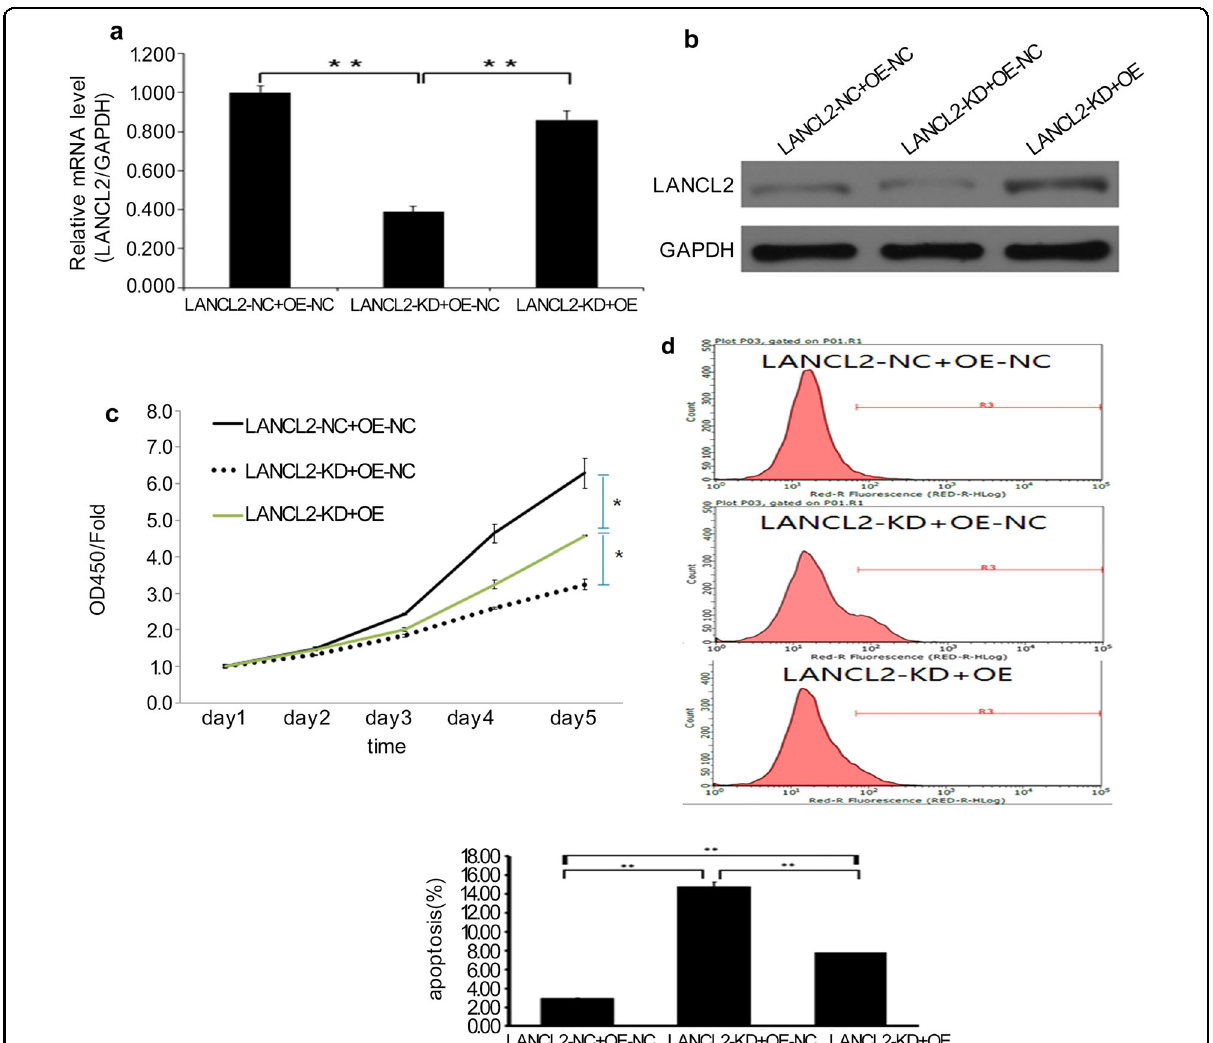
Fig. 5 LANCL2 overexpression rescues effects of LANCL2 knockdown in HCC827 cells. a mRNA and b protein expression levels of LANCL2 in negative control (LANCL2-NC + OE-NC), LANCL2 knockdown (LANCL2-KD + OE-NC), and LANCL2 knockdown with LANCL2 rescue overexpression (LANCL2-KD + OE) HCC827 cells. c CCK-8 cell proliferation assay and d fl ow cytometry analyses of apoptosis using Annexin V staining in infected HCC827 cells. * p < 0.05; ** p < 0.01; and *** p < 0.001 vs. LANCL2-NC + OE-NC. Data presented as means ± SDs. All in vitro experiments: three biological replicates × three technical